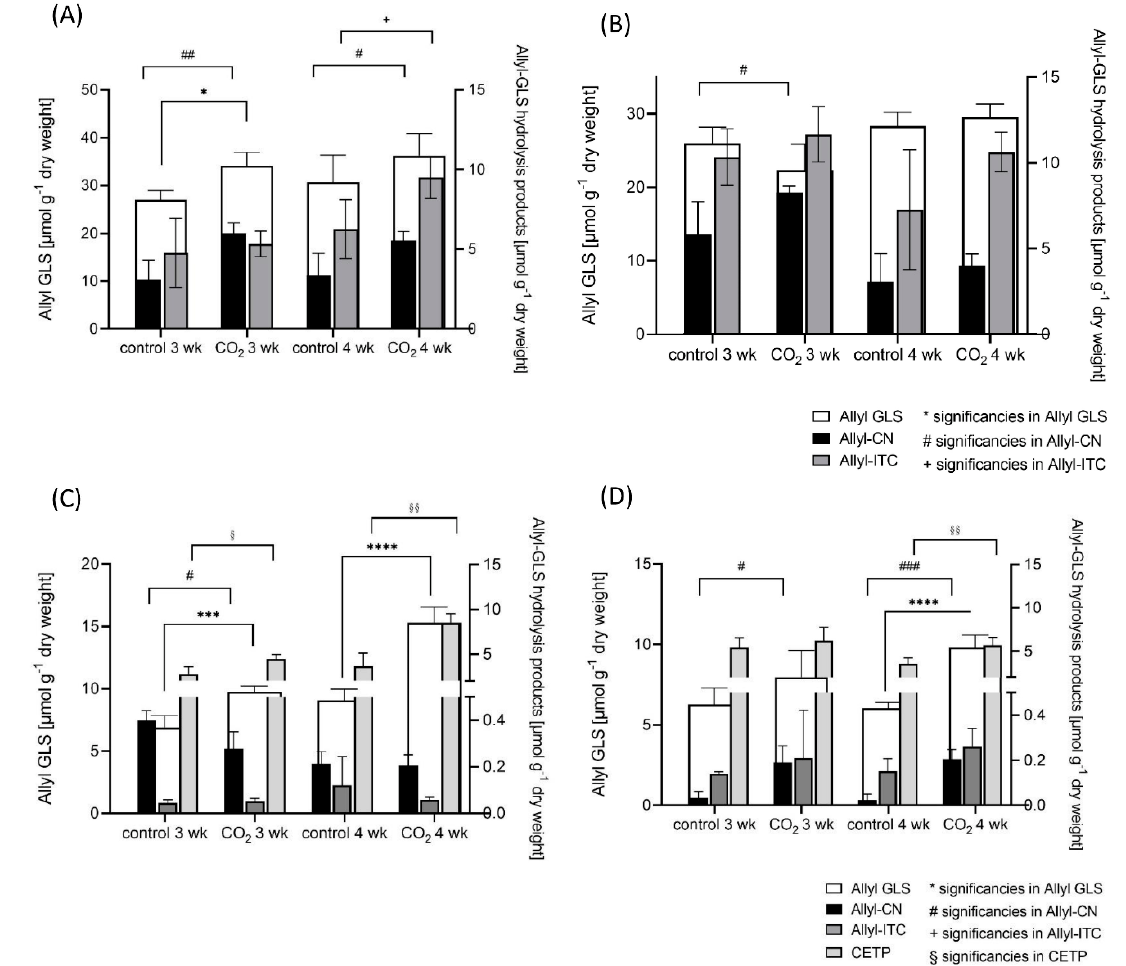
Fig. 4: Effect of elevated CO 2 on allyl glucosinolate (GLS) and the formation of its hydrolysis products from A. thaliana . Elevated (2%) [CO 2 ] effects on allyl GLS and formation of its hydrolysis products in accessions Hi-0 (A, B: experiment I and II) and Bur-0 (C, D: experiment I and II) were compared to ambient air (0.04% [CO 2 ]) (control) after three and four weeks (wk). Averages and standard deviations of biological replicates (n= 4-5) are shown for two experimental replications (A, B and C, D) separately. Significant differences are marked with symbols (*, #, +, §; for example *, p < 0.05; **, p < 0.01; ***, p < 0.005; unpaired t-test). Abbreviations: Allyl-CN: 3-butenenitrile, Allyl-ITC: allyl isothiocyanate, CETP: 1-cyano-2,3-